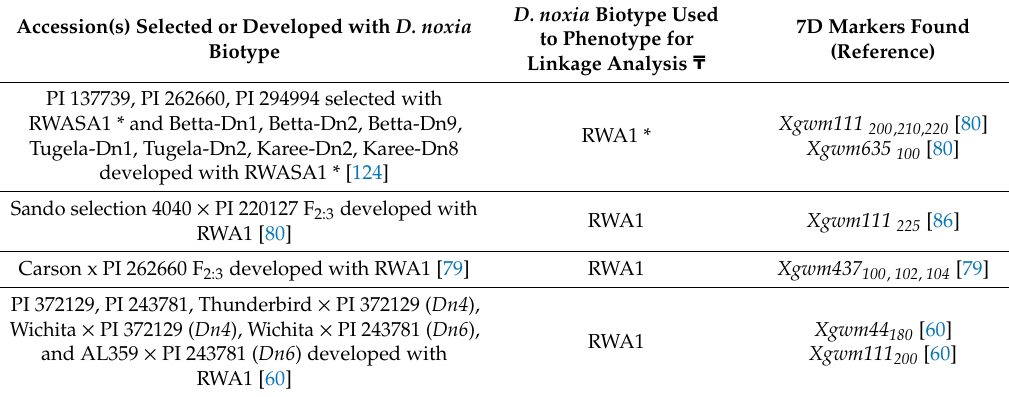
Table 4. Biotype(s) used for selection and/or development of wheat accessions, for the linkage analysis phenotyping and 7D marker alleles reported in the literature.